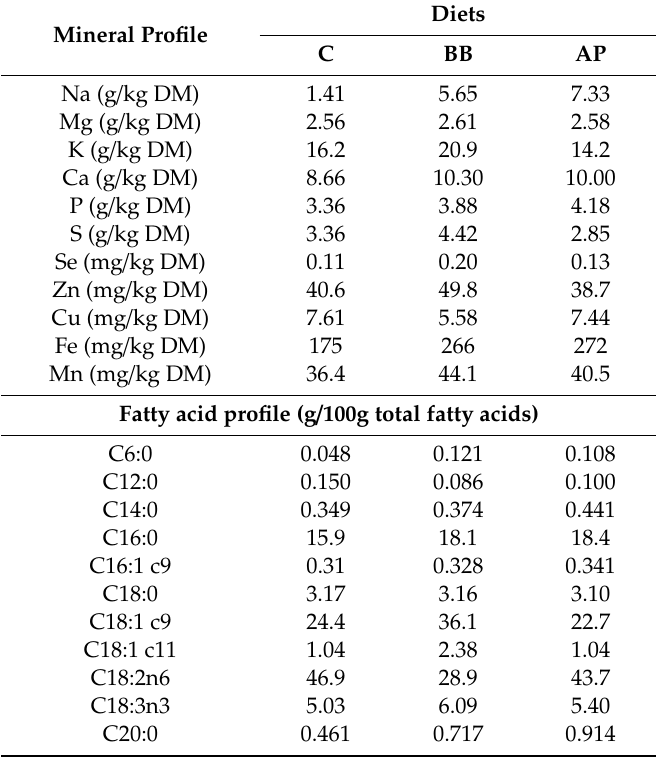
Table 2. Mineral and fatty acid profile of experimental diets provided to goats of the present